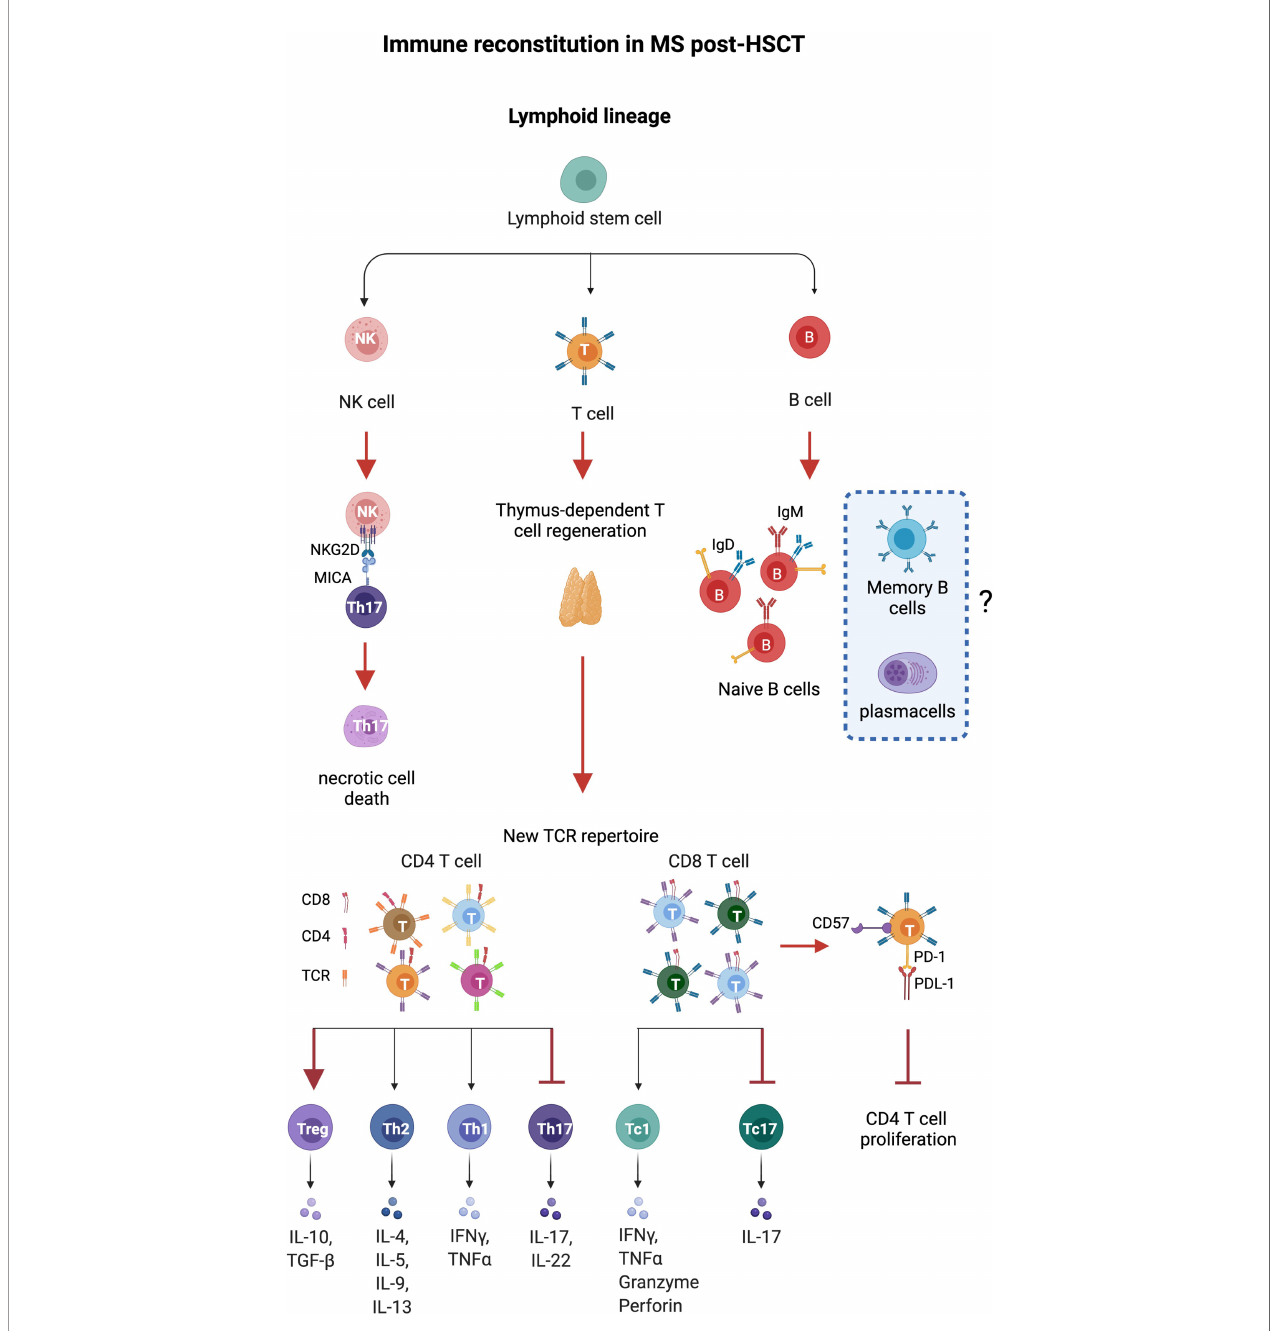
FIGURE 1 | Immune reconstitution in MS after HSCT. Thymus-dependent T cell regeneration and immune regulation mediated by T and natural killer (NK) cells constitute the major identi fi ed pathways in fl uencing immune reconstitution in patients with MS after HSCT. Thymus-derived CD4 T cells show a new, diverse repertoire and deletion of preexisting CD4 clones. CD8 T cells show an incomplete renewal of TCR repertoire suggesting expansion of residual or regenerated virus- speci fi c clones. Increase of regulatory CD4 + FOXP3 + , CD8 + CD57 + T cells, and NK cells and eradication of pro-in fl ammatory Th17 and Th17-1 cells (MAIT) are observed after HSCT. NK cells induce necrotic cell death in Th17 and Th17-1 cells by the NKG2D pathway, while CD8 + CD57 + cells suppress CD4 + T cell proliferation. Anergy is reported on CD8 + T cells that express high levels of CD57, a marker of senescence, and inhibitory effects are exerted by the immune checkpoint inhibitor PD-1. HSC, hematopoietic stem cells; CLP, common lymphocyte progenitor; NK regs, regulatory natural killer CD3-CD56 hi . Figure created with